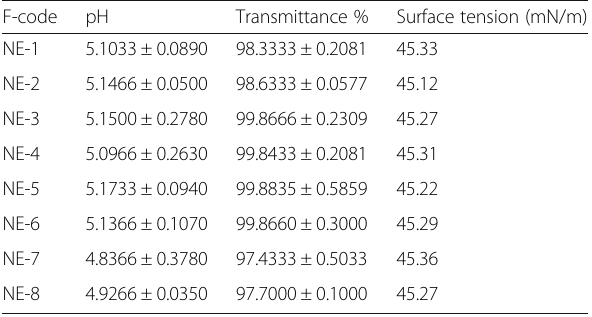
Table 6 Results of pH, transmittance percent and surface tension determination of candesartan cilexetil nanoemulsions